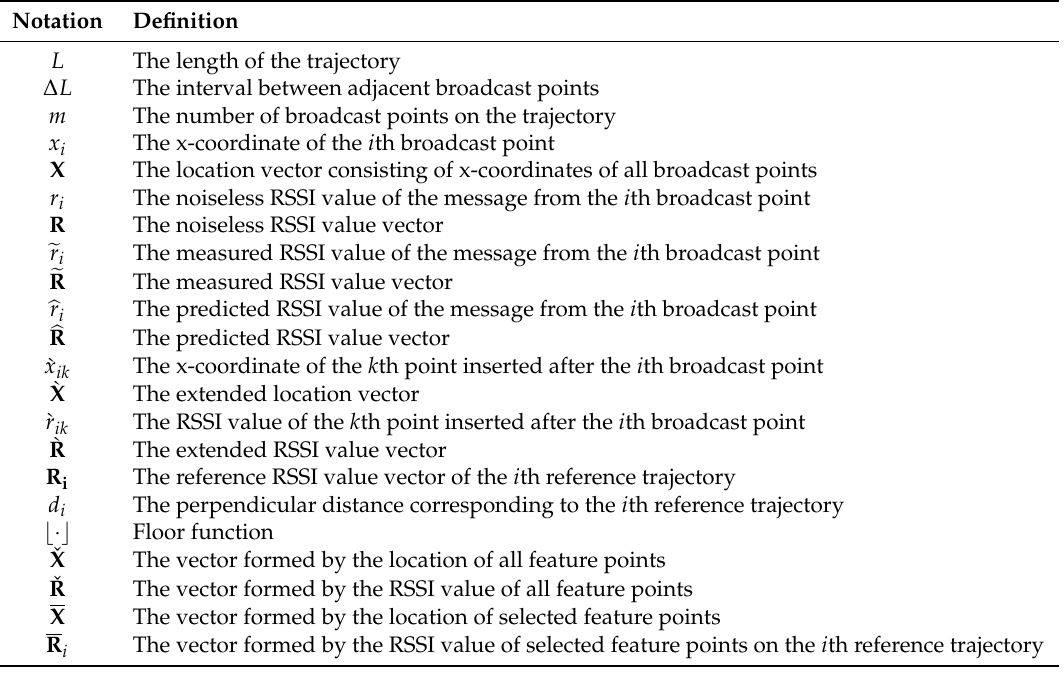
Table 1. Main notations used in this